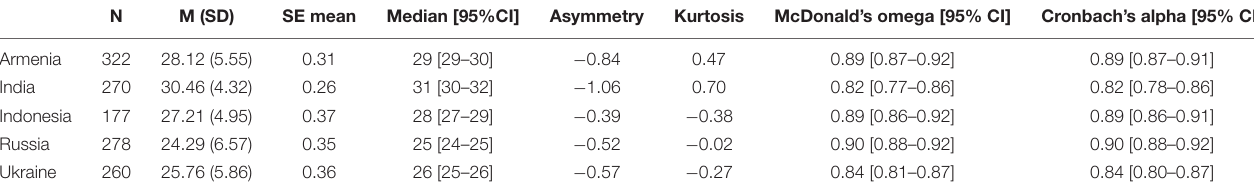
TABLE 1 | Descriptive statistics of the Short Home Attachment Scale across countries.